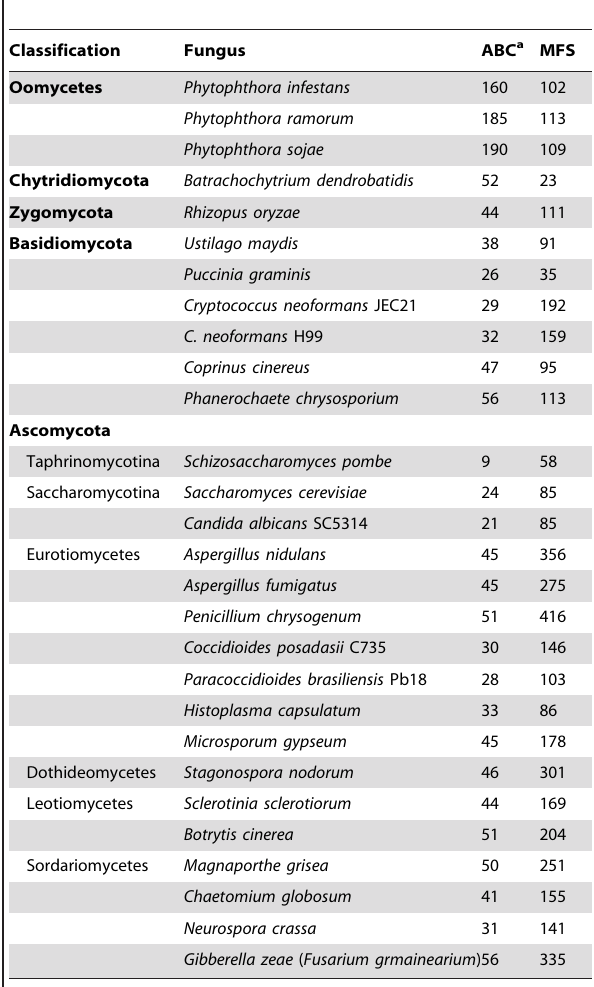
Table 2. Number of ABC and MFS Transporters in Sequenced Fungal and Oomycete